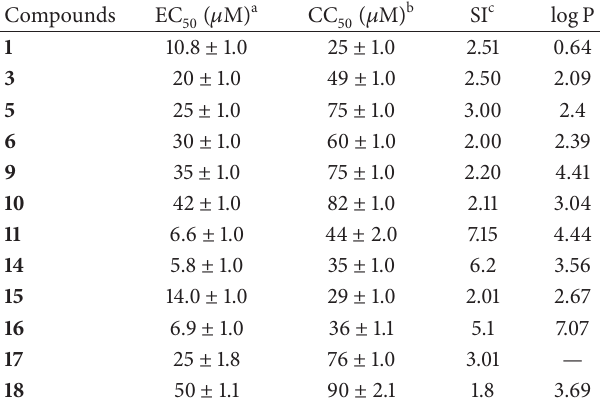
Table 1: Anti-HIV-1 activities of fluorinated 1,2,4-triazinones 1–18 .